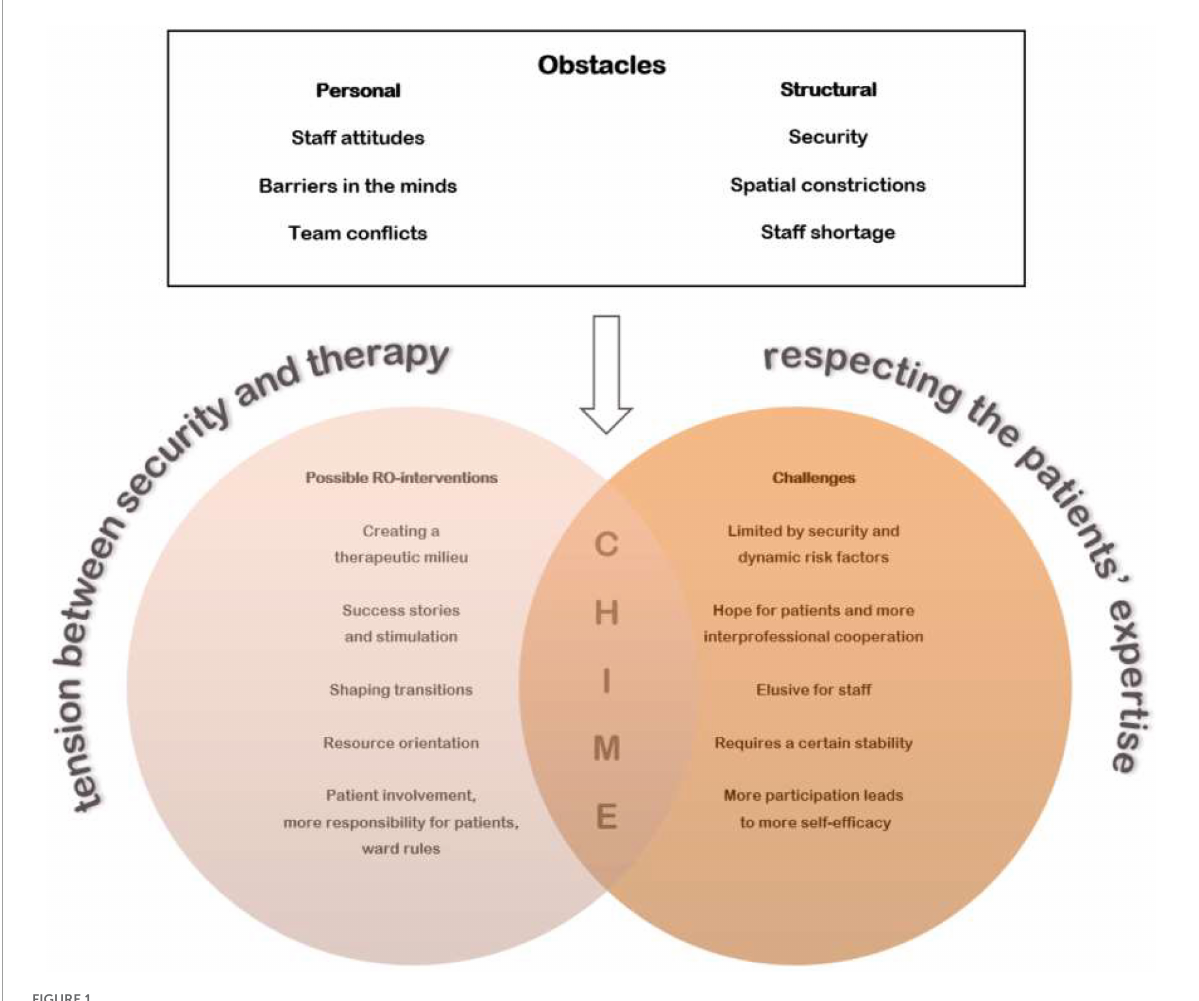
FIGURE1 Tentative RE-FOR-MA model of thematic interrelations on secure